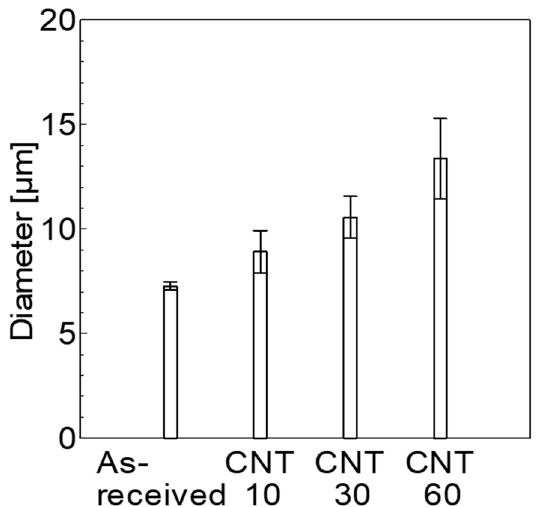
Figure 8. Schematic drawing of growth mechanism of carbon nanotube: ( a ) pushing up the metal particle; ( b ) growing up with the metal particles rooted on the surface of the substrate.